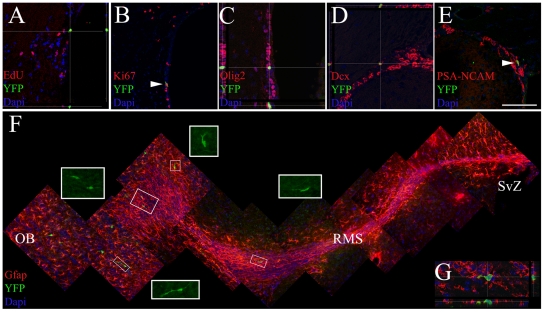

AspM is expressed cells of the adult SVZ sharing feature of progenitor cells.P30 AspM-CreERT2/Rosa26YFP mice (n = 4) were injected with Tam for 5 days. Mice were subsequently injected with EdU for further 5 days and then sacrificed. YFP+ cells were exclusively placed in the SVZ, as shown by confocal sectioning (A–E). YFP+ cells incorporated the EdU S-phase tracer (A), co-expressed Ki67 (B), Olig2 (C), Dcx (D) and PSA-NCAM (E). Scale bar 100 µm. Double transgenic mice (n = 4) injected with Tam as above, were also collected 17 days after the last Tam injection. Sagittal brain sections were probed for the detection of YFP+ cells along RMS and in OB. The position of the RMS, in each brain, was identified by staining slices for GFAP (F). The vast majority of YFP+ cells were located along RMS (F). Moreover, these cells displayed cellular processes which are typically of migrating neuroblasts (insets in F show high magnification of YFP+ cells detected in the RMS). Panel G shows a migrating YFP+ cell along the RMS, co-expressing PSA-NCAM. Scale bar100 µm.